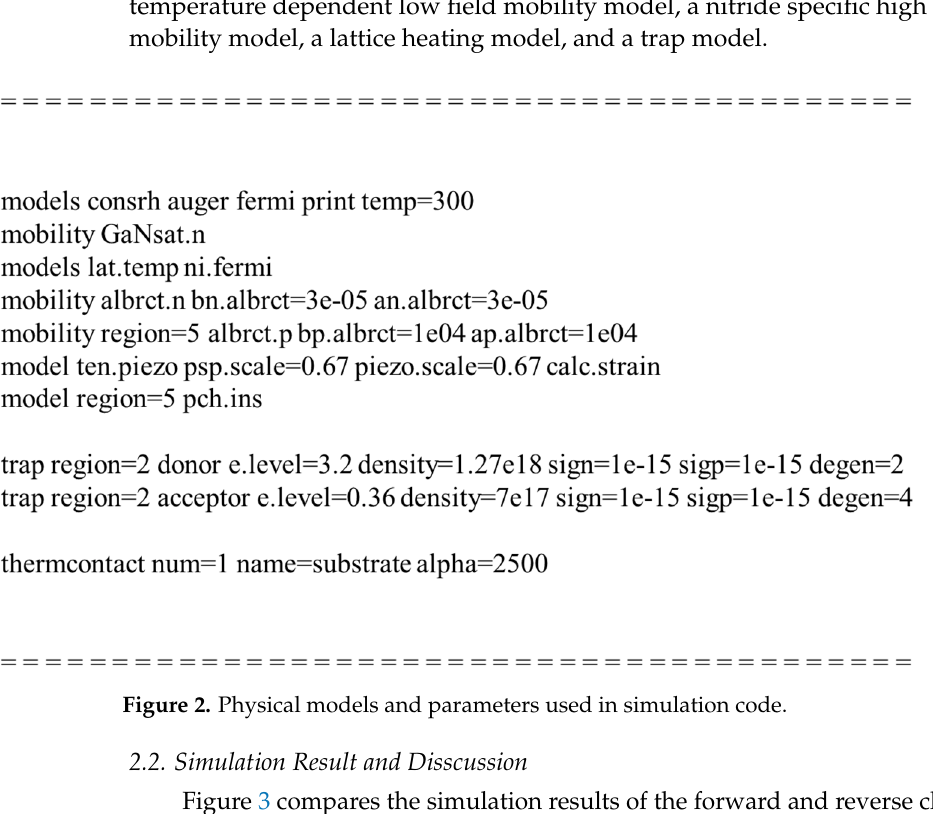
Figure 1. Cross-sectional schematics of ( a ) p-GaN gate AlGaN/GaN heterojunction field-effect transistor (HFET) and ( b ) unidirectional HFET.